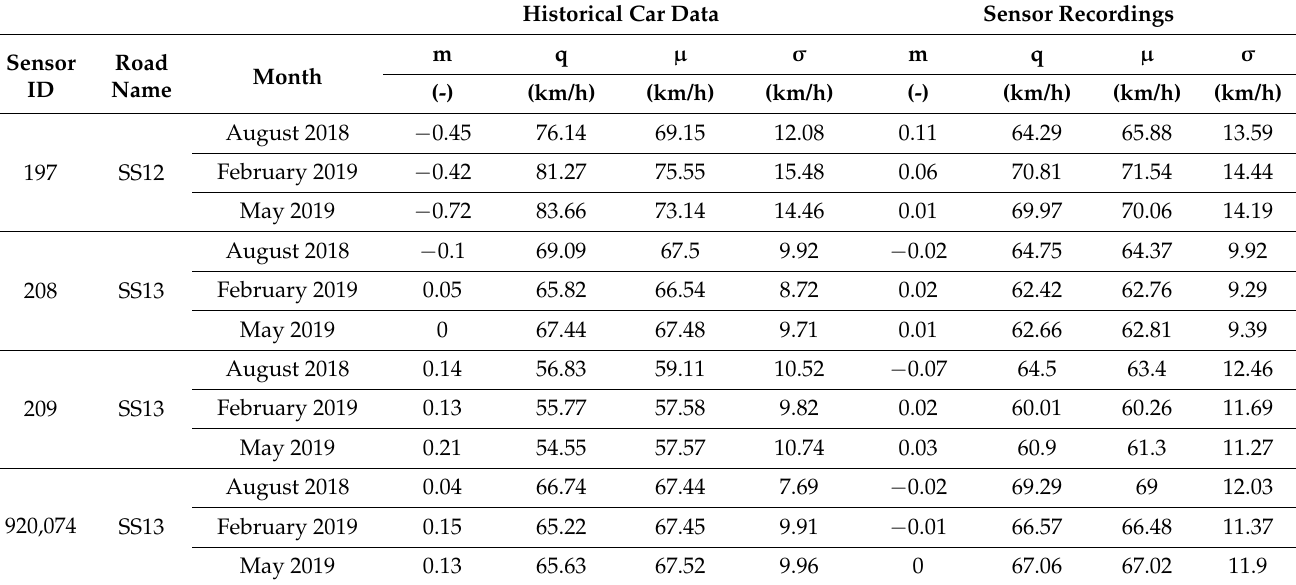
Table A2. HCD and sensors angular coefficients m, and intercepts q of the regression lines, average speeds µ , and the standard deviations σ referred to each monitored month in Dir